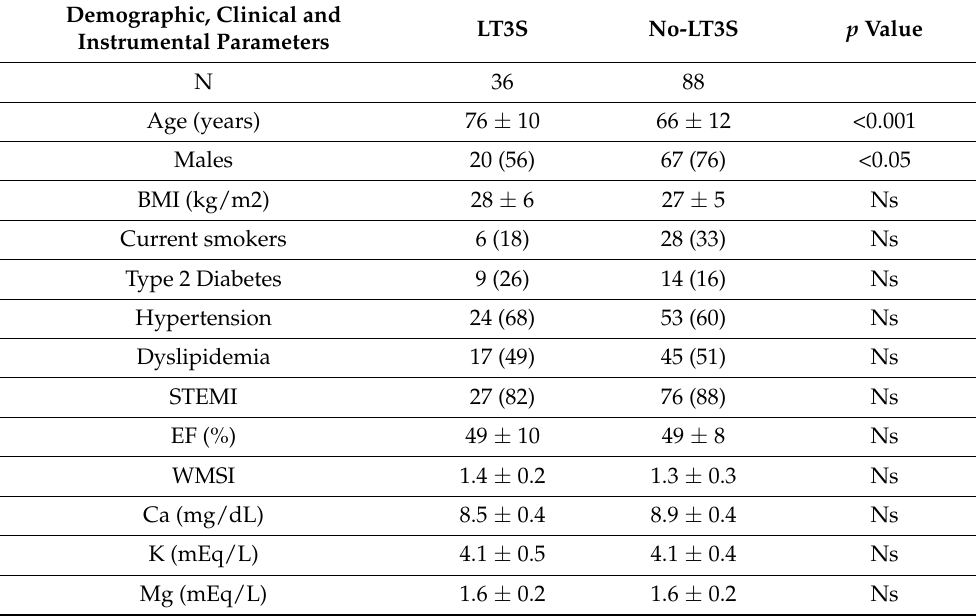
Table 1. Demographic, clinical, and laboratory characteristics of the overall population with acute myocardial infarction (AMI). Demographic, Clinical